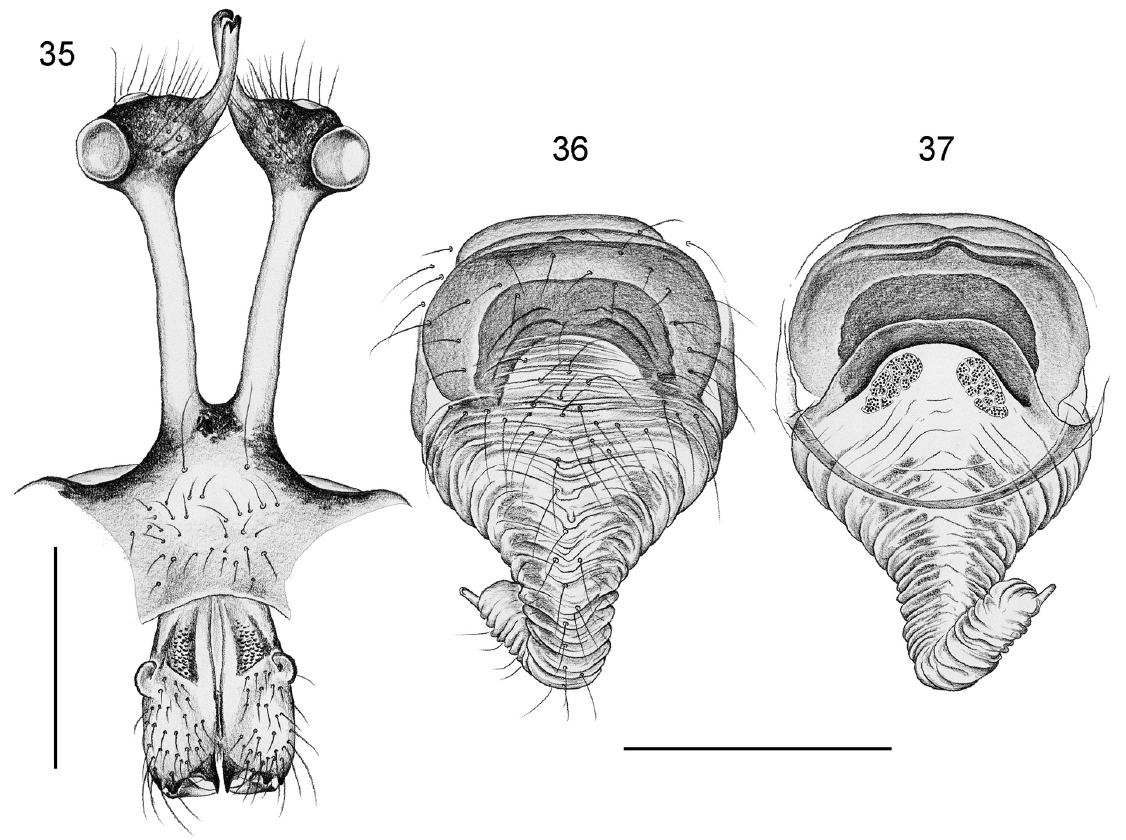
Figs 35–37. Panjange camiguin Huber sp. nov. (ZFMK, Ar 13003, 13004). 35 . Male prosoma and chelicerae, frontal view. 36–37 . Cleared female genitalia, ventral and dorsal views. Scale bars = 0.5